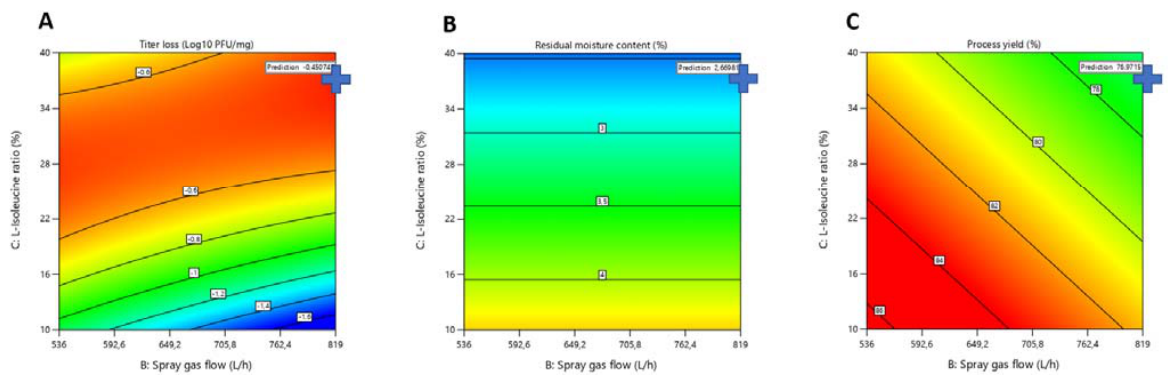
Figure 5. LUZ19 contour plot: Representation of Titer loss ( A ); Residual Moisture Content ( B ); and Process yield ( C ) against combinations of Spray gas flow and L ‐ isoleucine ratio factors.